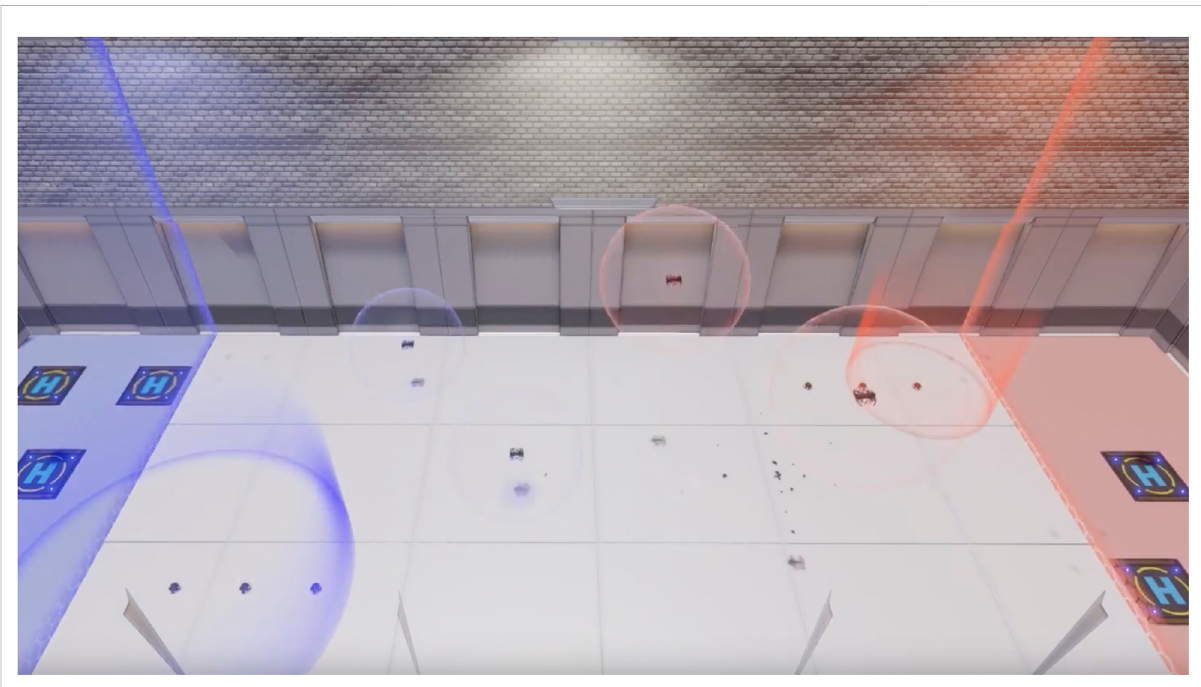
FIGURE 2 LivegameofCapture-the-Flaginthesimulatedlabarena.Thisgameshowsa3v3(technicallya(3+3)v(3+3)with3UAVsand3UGSsperteam) with the blue team endzone on the left and the red team endzone on the right. At this point in the game, 1 UAV in each team has been